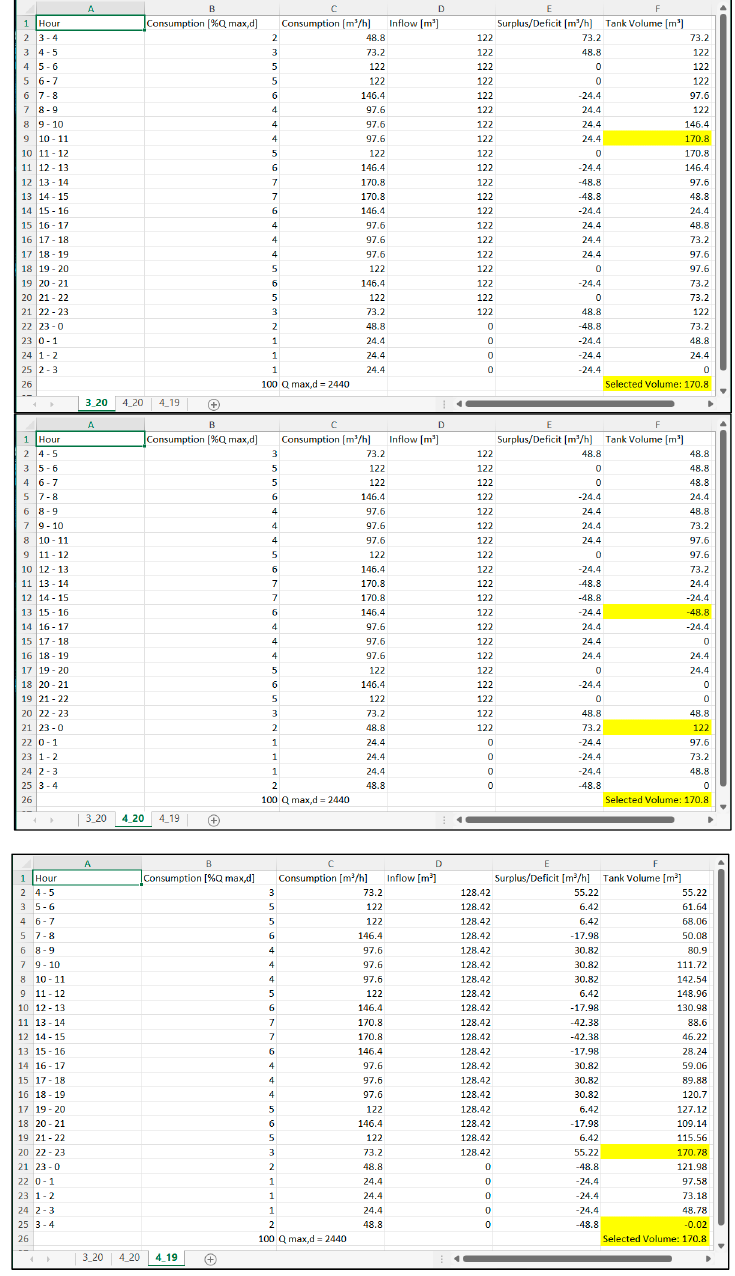
Figure 9. Screenshot of the obtained results (created MS excel file) for Variant I—multiple (3×) solutions (sheets) with minimum water tank volume.